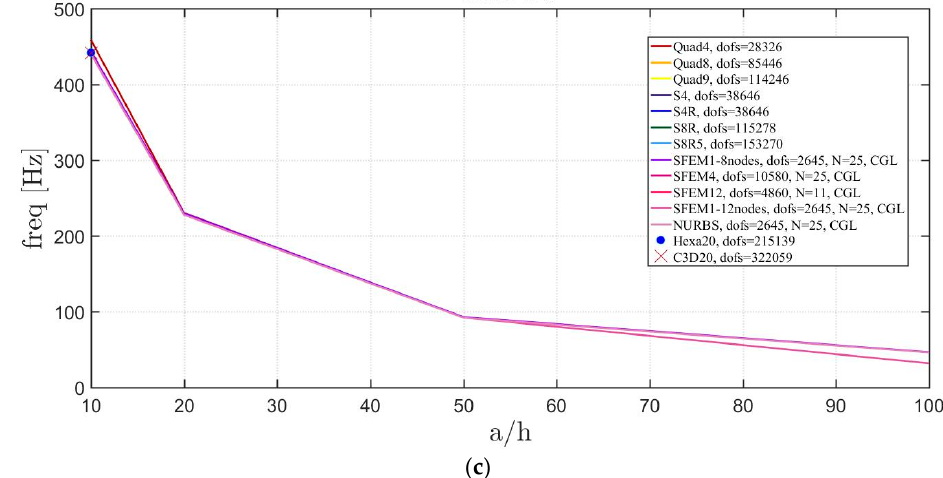
Figure 10. Thickness effect on the first three natural frequencies of an isotropic elliptic plate with a / b = 1.5: ( a ) First frequency; ( b ) Second frequency; ( c ) Third frequency.